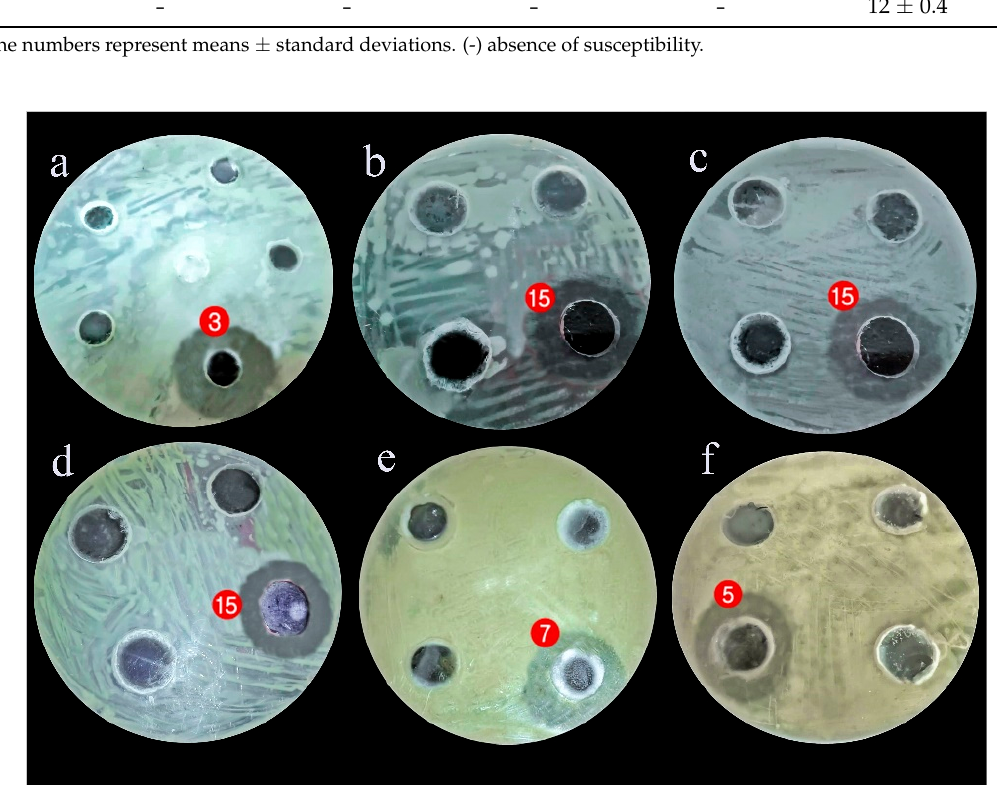
Figure 2. Matrix cluster analysis based on two-way single linkage Euclidian distance showing the level of antagonistic activity of bacterial symbionts isolated from P. americana L. against tested MDR pathogenic bacteria .